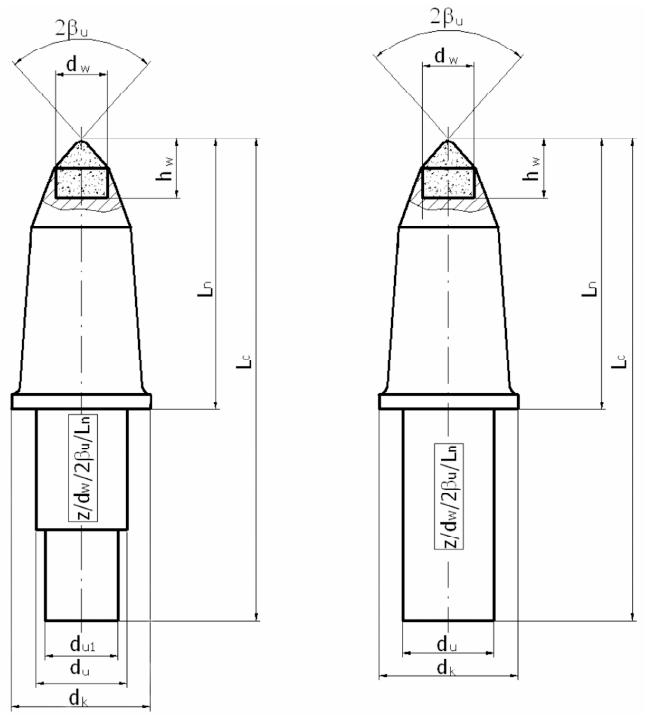
Figure 5. Two- and single-stage conical pick with its measured design parameters [28,29]. The linear dimensions were measured using an altimeter (maximum permissible error ± 40 µ m) and a calliper (maximum error ± 30 µ m), while the angles were measured with a protractor characterised by a maximum permissible error of ± 2 ◦ ). Figure 6 presents picks on this particular measuring base, equipped with an altimeter, calliper and